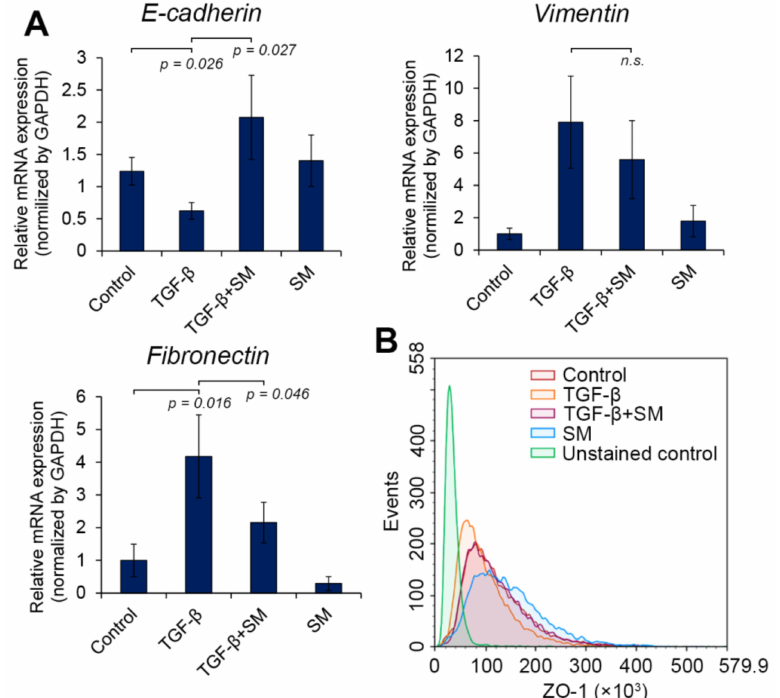
Figure 6. SM switches expression of EMT-associated molecular markers to epithelial ones in TGF- β stimulated A549 cells. The cells were treated with TGF- β (50 ng / mL) and / or SM (0.5 µ M) for 48 h followed by evaluation of E-cadherin, vimentin and fibronectin mRNA ( A ) and ZO-1 protein ( B ) expression using RT-PCR and flow cytometry, respectively. Relative expression levels in A were shown as mean ± standard deviation from two independent experiments performed in